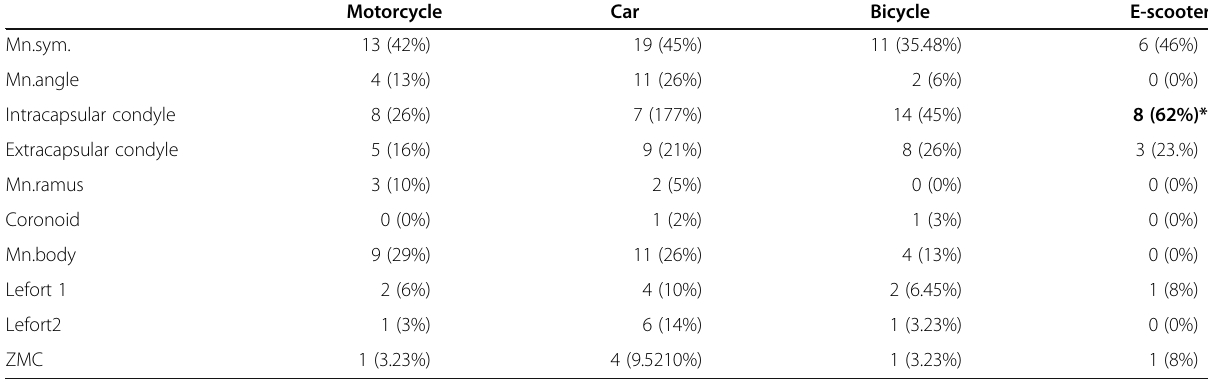
Table 3 MVA (motor vehicle accidents) and oral and maxillofacial fracture site Motorcycle Car Bicycle E-scooter Mn.sym.